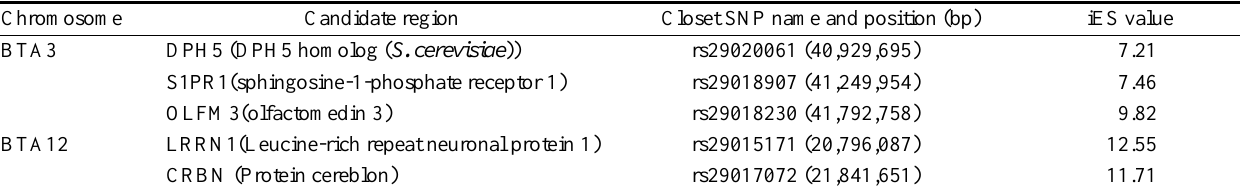
Table 1. Summary statistics of the integrated EHHS (iES) values for selection signature in candidate genes Chromosome Candidate region